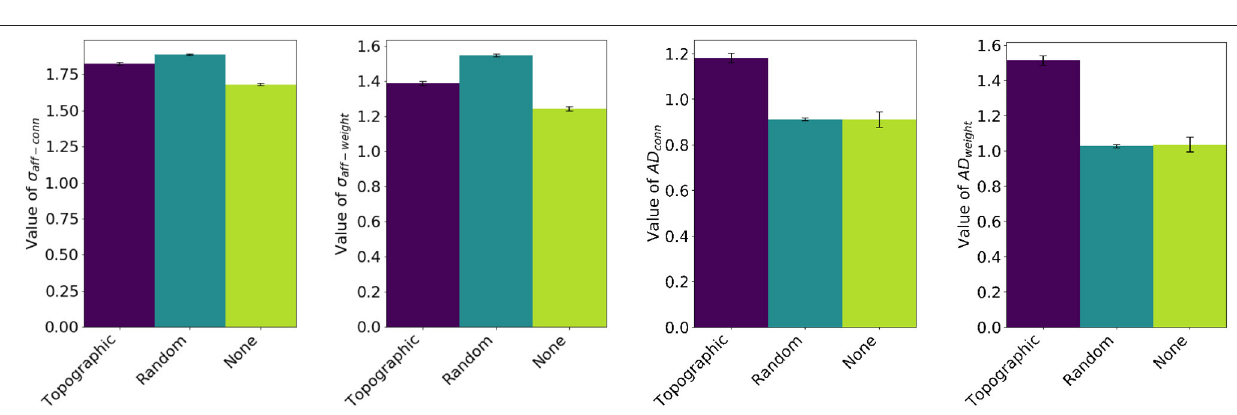
Frontiers in Neuroscience |